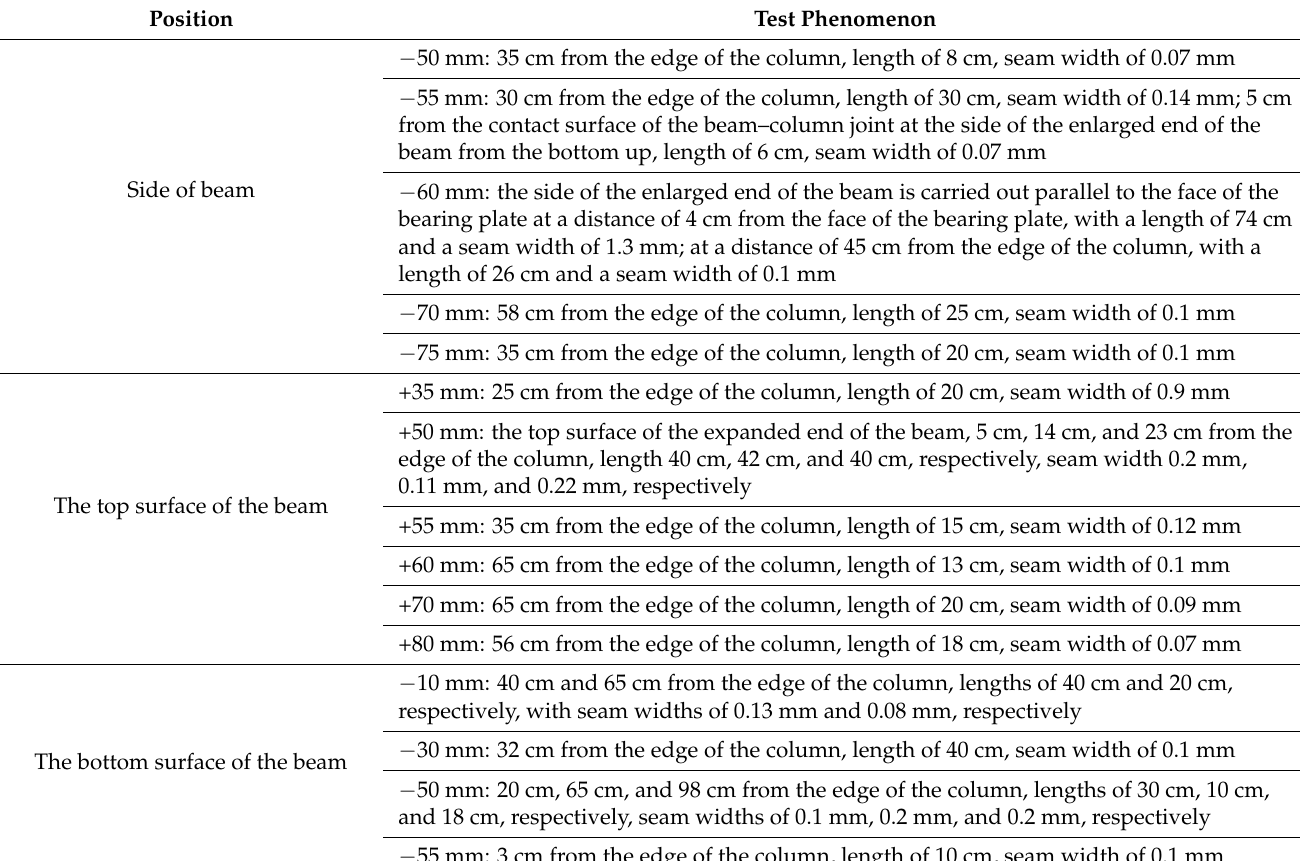
Table 8. Test phenomena of specimen